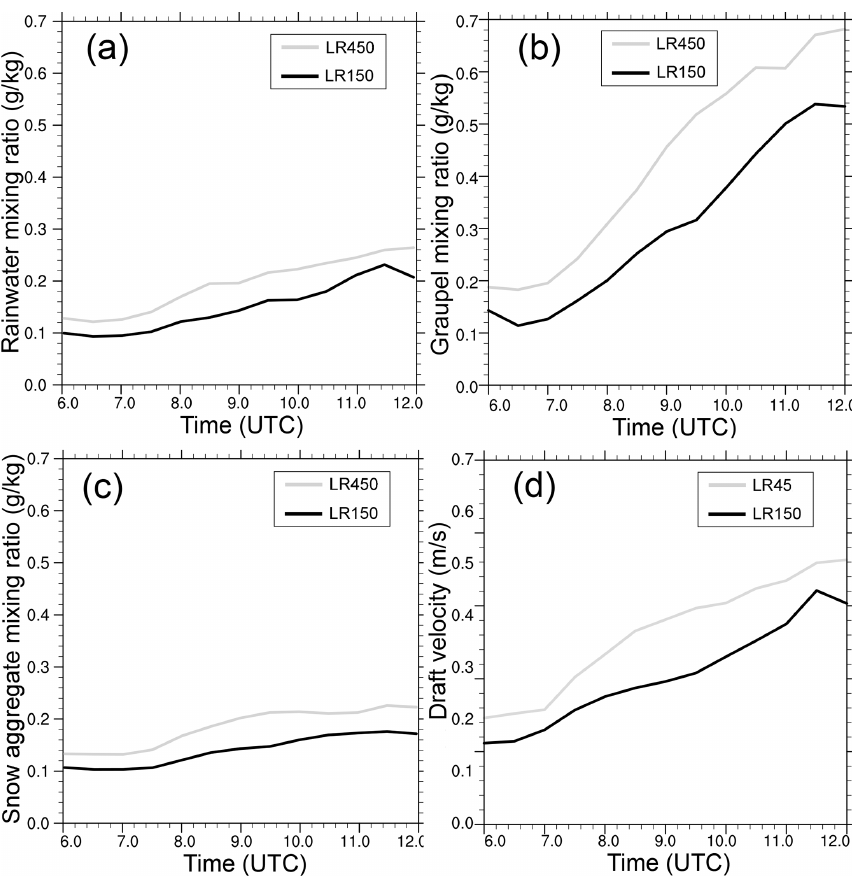
Figure 9. Time series of: (a) rainwater mixing ratio, (b) graupel mixing ratio, (c) snow aggregate mixing ratio, and (d) the 90th percentile of vertical velocities for LR450 and LR150 experiments,d averaged over the whole subdomain seen in Fig.